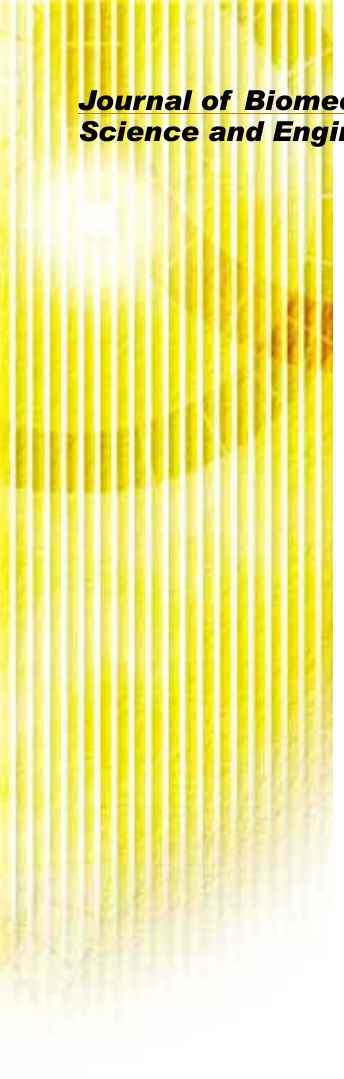
Fig.5 Frequency patterns of normalized attenuation for at three amplitudes of noise (0%, 6% and 9%) obtained by the four methods. The panels are arranged in the same way as was done for the phase velocity data